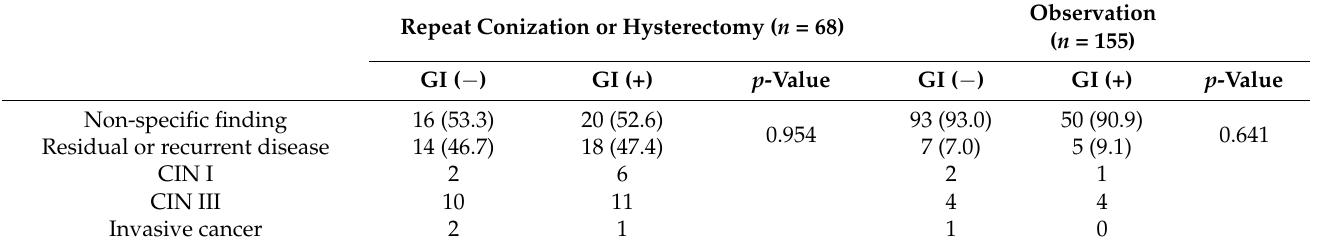
Table 4. Prognosis of clinical management according to the glandular involvement status. Repeat Conization or Hysterectomy ( n = 68)